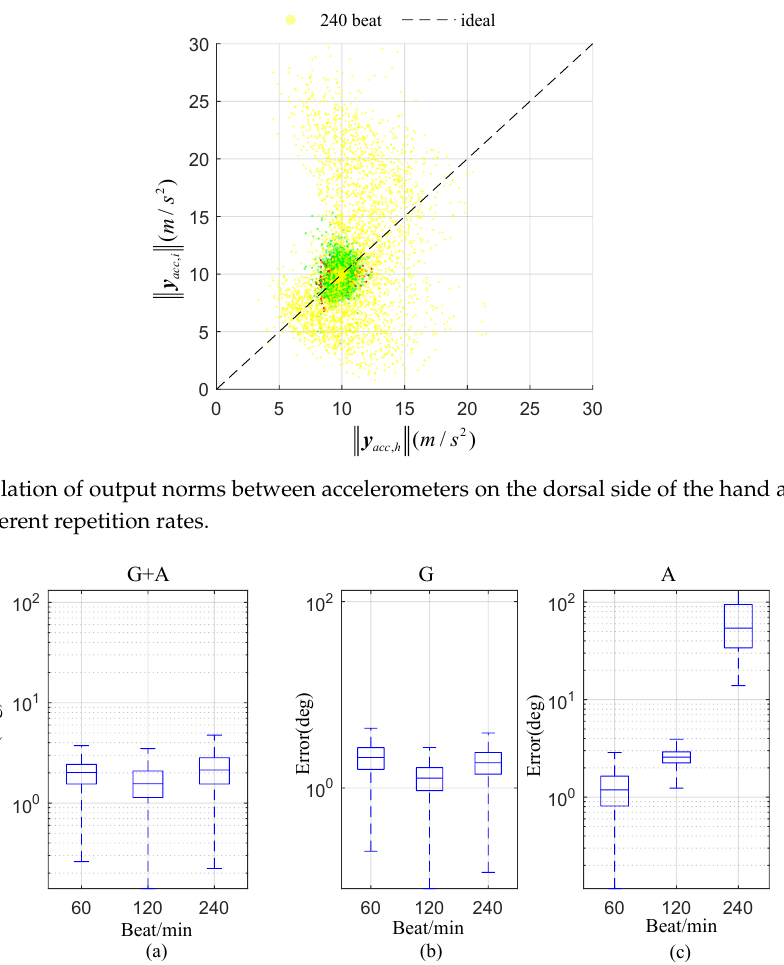
Figure 7. Estimation error | θ err | with different repetition rates (values under 99.3 percent coverage are shown in the boxplot figures). Subfigures ( a – c ) are estimations with gyroscope plus accelerometer, and gyroscope and accelerometer